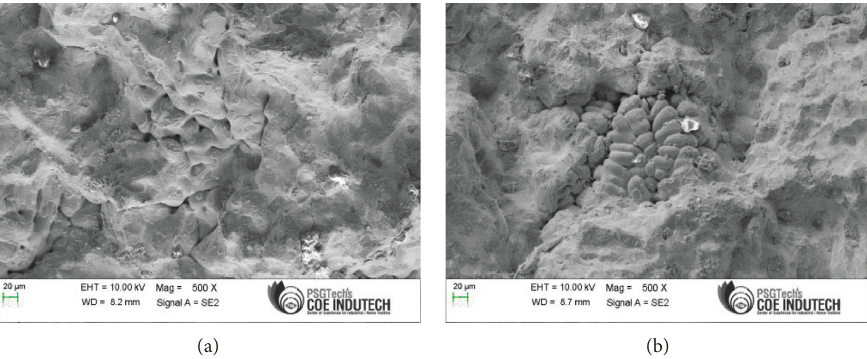
Figure 15: SEM analysis of fractured fatigue samples: (a) AA7075 and (b) AA7075/0.5wt%TaC/4wt% Si